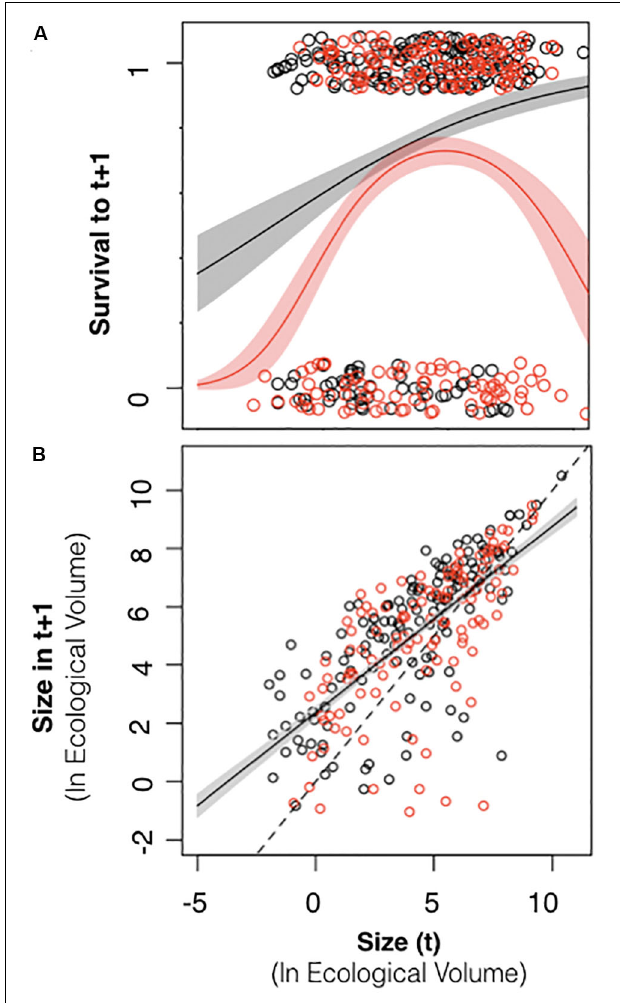
FIGURE 7 | Relationship between colony size and colony survival and growth. (A) Black symbols relate colony size in 2015 to the probability of surviving to 2016 (0 or 1). Red symbols relate colony size in 2016 to the probability of surviving to 2017. In 2015–2016, larger colonies exhibited higher survival across the entire size range (black line with 95% confidence intervals depicted in gray). In 2016–2017, colonies of an intermediate size exhibited the highest survival (red line with 95% confidence intervals depicted in pink). (B) Black symbols relate colony size in 2015 to colony size in 2016. Red symbols relate colony size in 2016 to colony size in 2017. The dashed line represents unity. The R function jitter was used to display overlapping data values (R Core Team., 2018).